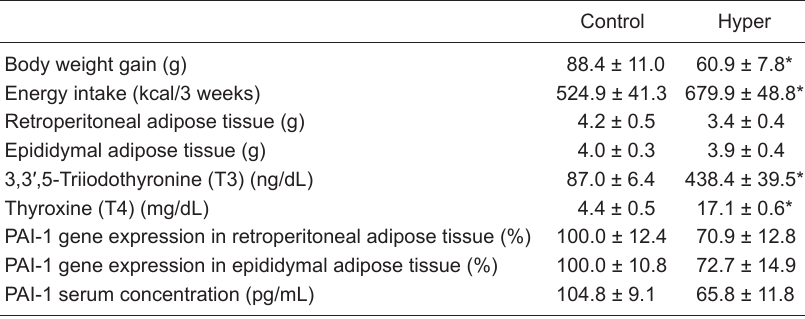
Table 1. Body weight gain, energy intake, weight of retroperitoneal and epididymal adipose tissue, serum concentrations of T4 and T3, PAI-1 gene expression in retroperitoneal and epididymal adipose tissues, and serum concentration in rats treated with saline (control) or T4